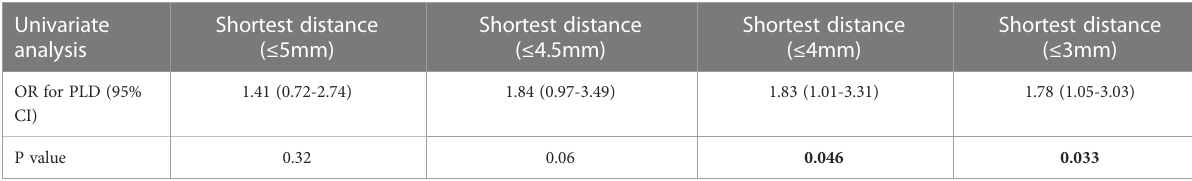
TABLE 7 Optimal shortest distance threshold in differentiating PLD with no PLD by reduction of 0.5mm.